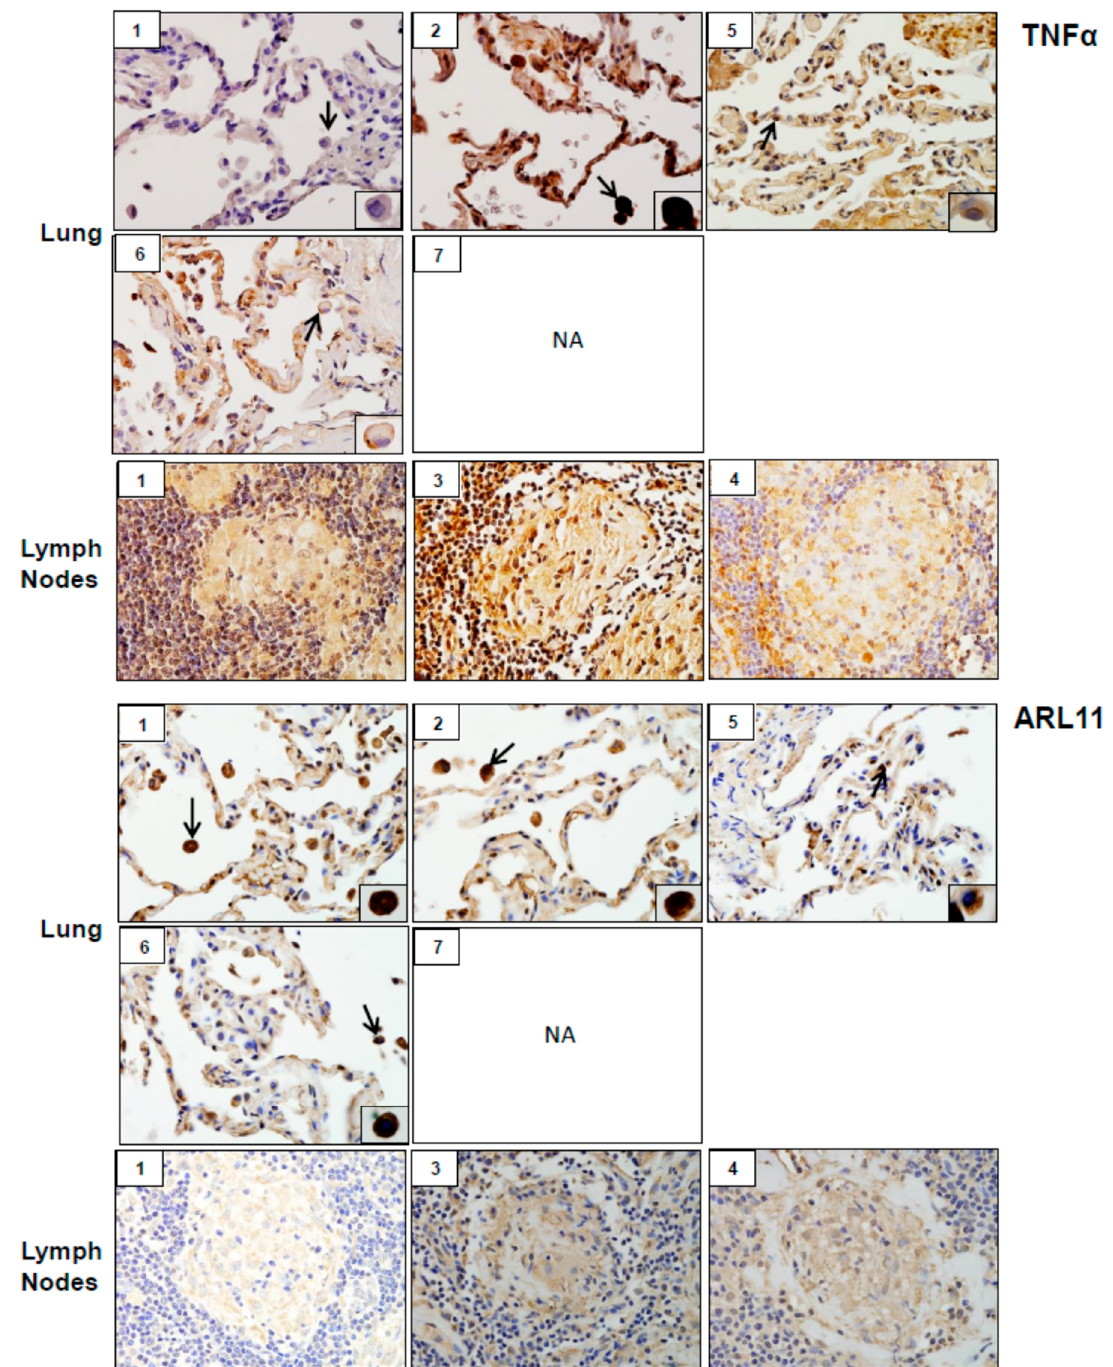
Figure 6. Tumor necrosis factor (TNF) α and ADP-ribosylation factor-like GTPase (ARL)11 expression in lung and/or lymph nodes collected from WTC rescue and recovery workers. Sections were immunostained with antibody to TNF α or ARL11. Binding was visualized using a DAB peroxidase substrate kit. One representative section from each patient is shown. Inset, patient number; NA, tissue not available. Magnification, 60×; arrows, alveolar macrophages.